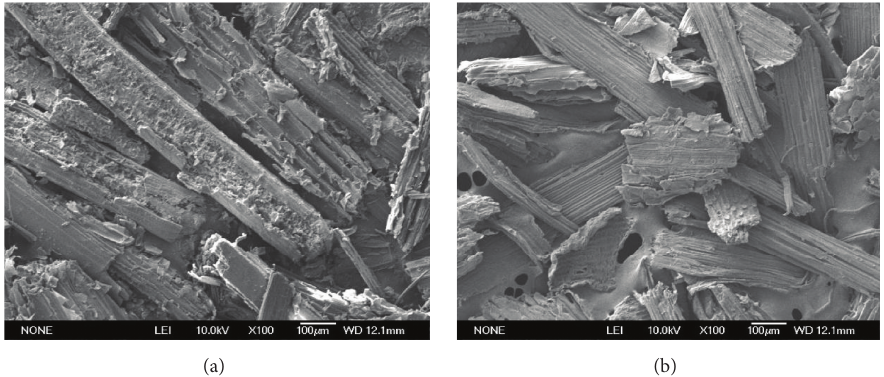
Figure 8: SEM of untreated wheat straw (UWS) (a) and alkali-treated wheat straw (AWS)